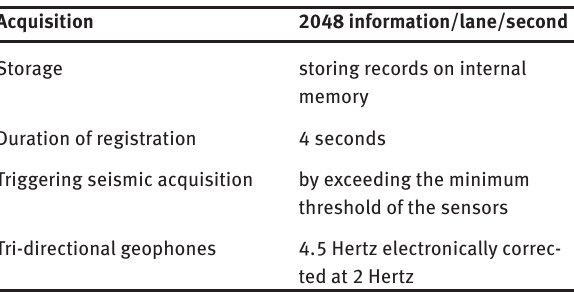
Table 3: Technical specifications of “Mini seis” measuring device [43] .